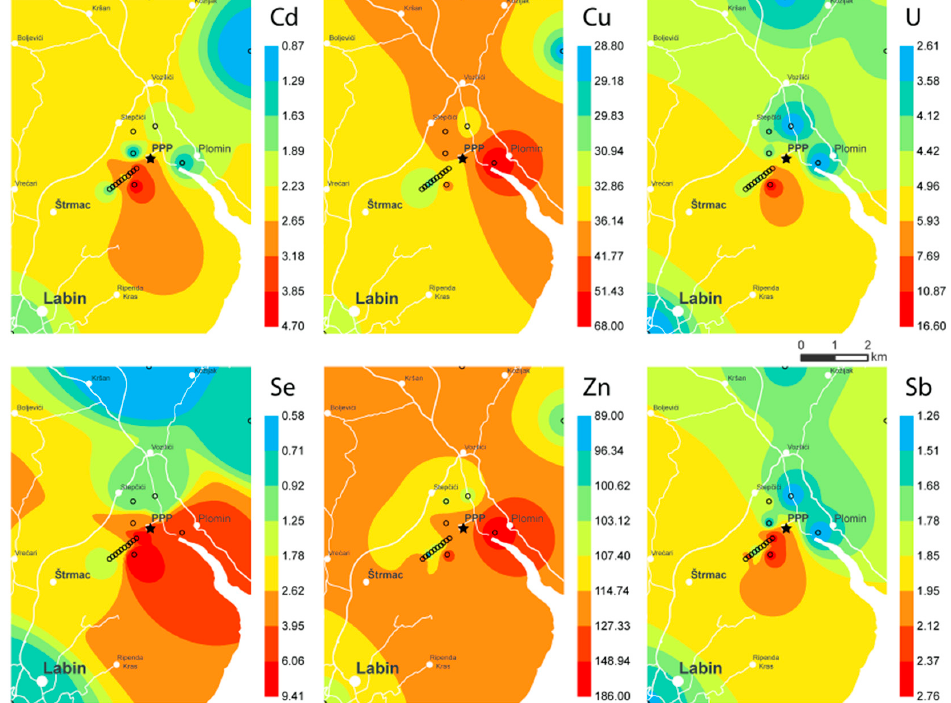
Figure 2. Soil selenium and trace metal contour maps.